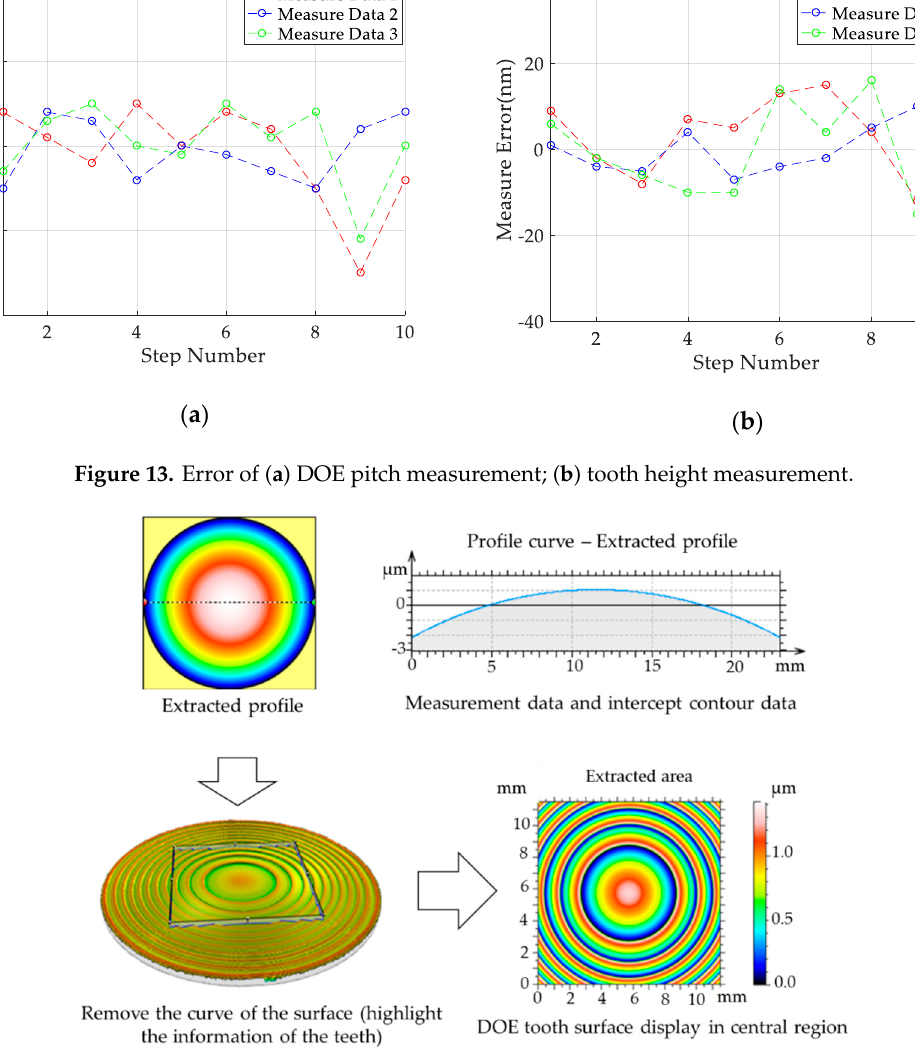
Figure 14. Measured data processing results.